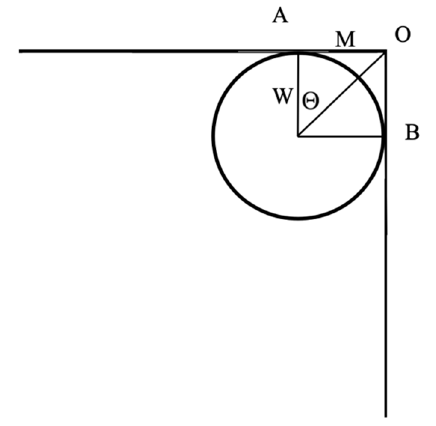
Figure 2. Construction of smooth tube.